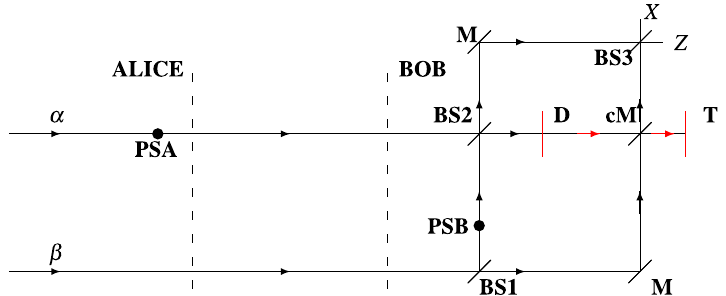
Figure 1. Mach–Zehnder interferometric scheme of the proposed relativistic QKD model. PSA phase shift possessed by Alice, PSB phase shift possessed by Bob, α signal coherent state, β reference coherent state, BS beam splitter, M mirror, cM controlled mirror, T terminator, PSA phase shift possessed by Alice, D detector, Z Z -basis measurement system, X X -basis measurement